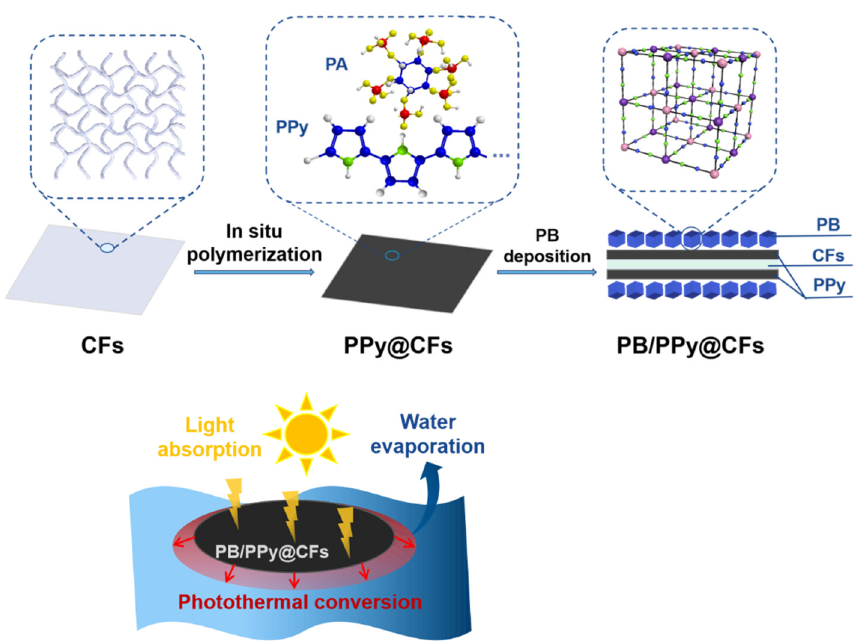
Scheme 1. Schematic illustration of preparation and photothermal interfacial water evaporation application of PB/PPy@CFs